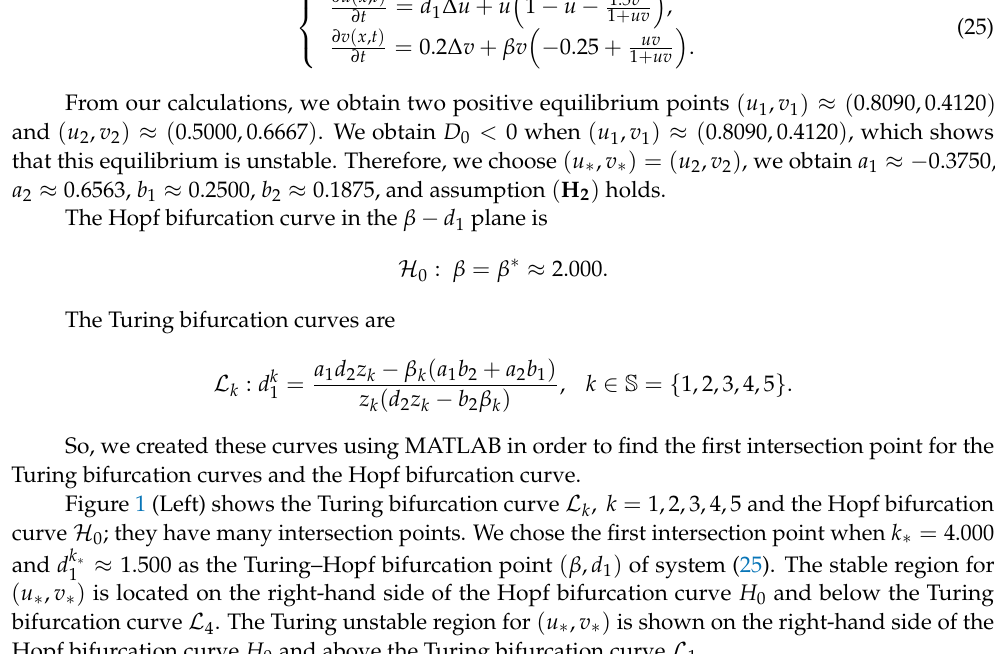
Figure 1. Left : some regions of ( u diagram, which is described more in Proposition